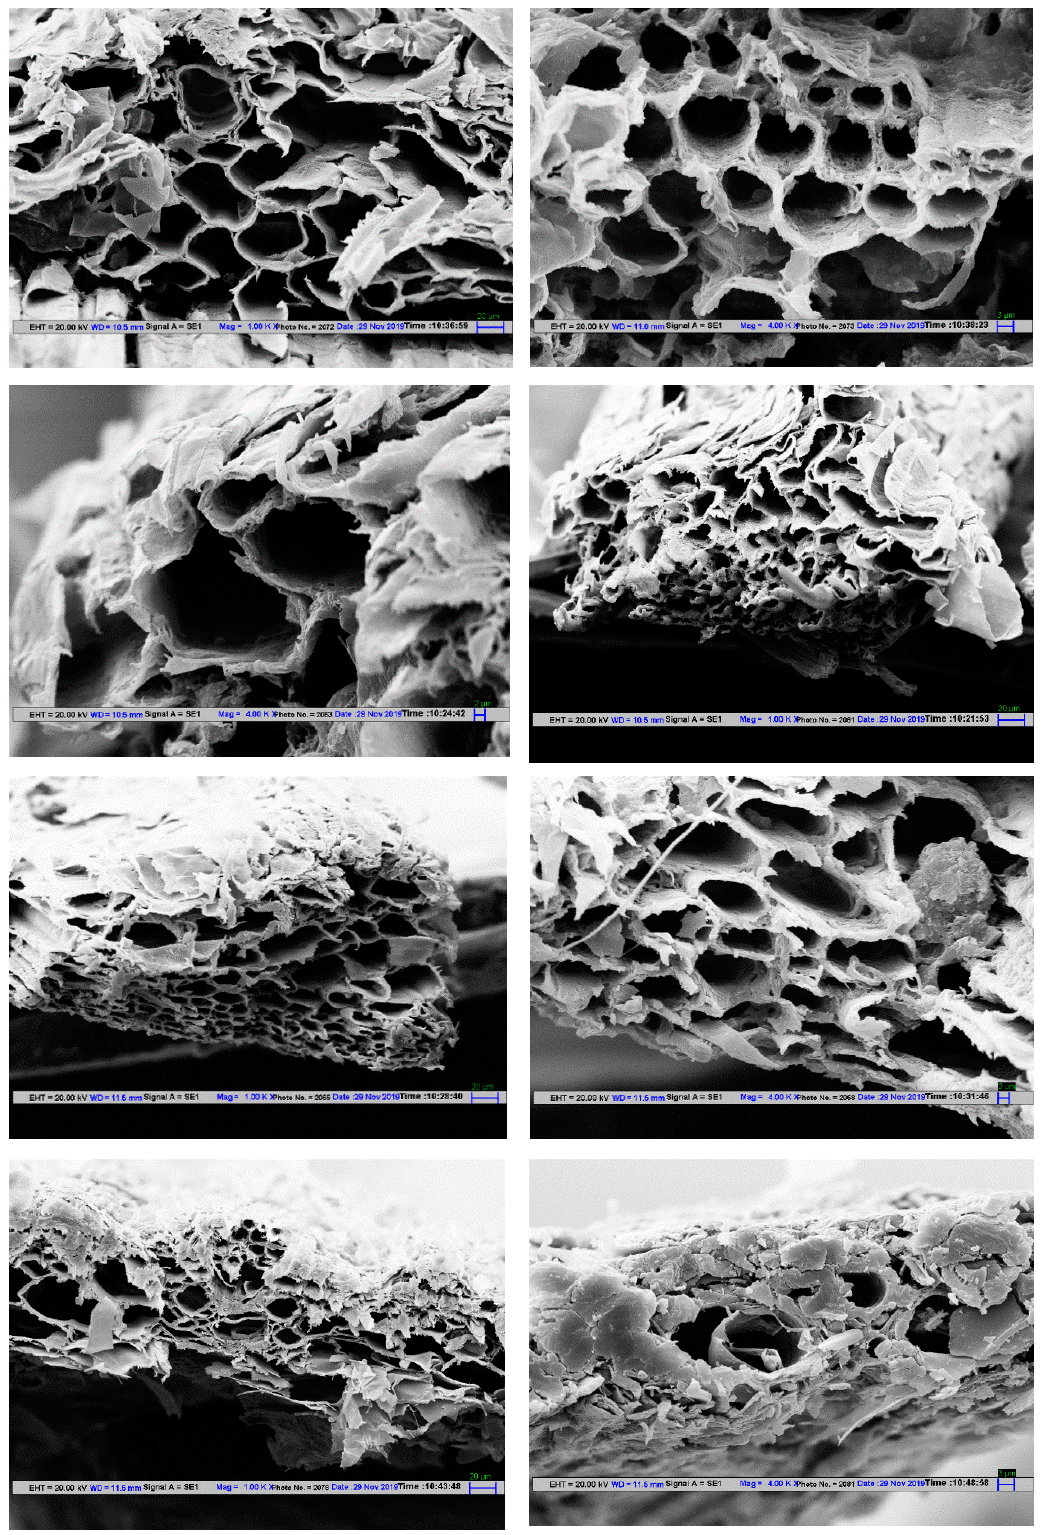
Figure 5. Scanning Electron Microscopy (SEM) images of a vertical cross section of Indigenous cow dung fiber (IDF), Buffalo dung fiber (BDF), Jersey cow dung fiber (JDF) and wheat straw (WS) (untreated) (Left side: ×1000, Right side: ×4000).